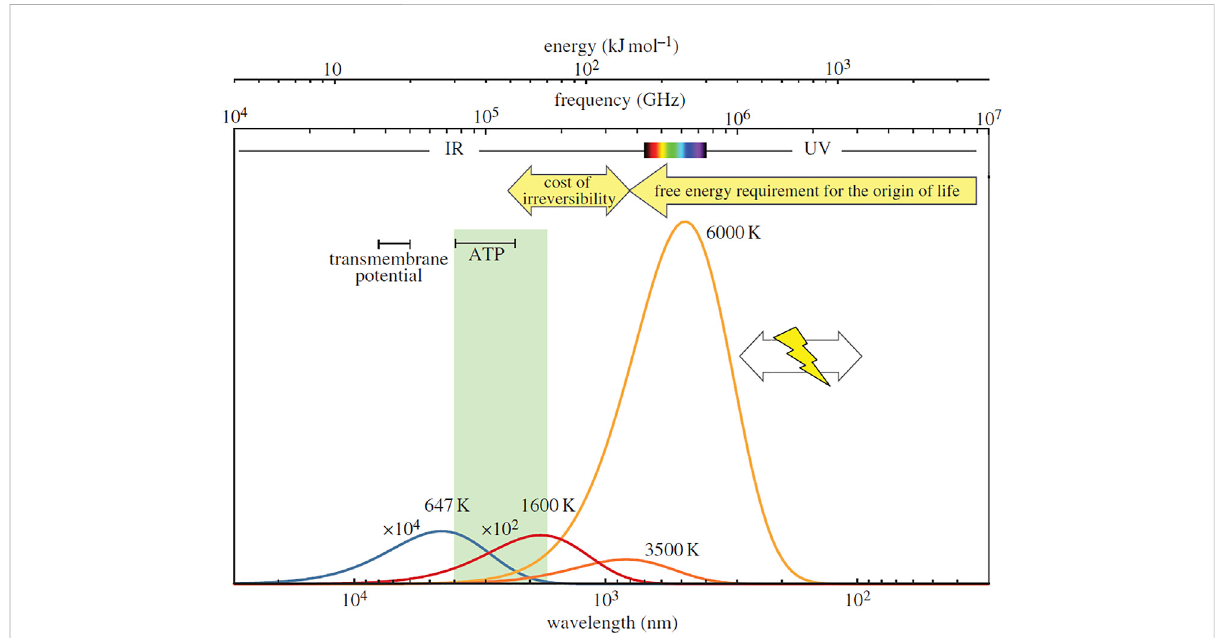
FIGURE 7 Freeenergysource requirements inlivingsystems(afterPascaletal.,2013).Theenergyavailableatthecriticalpointofwater (at647 K)isshown bytheblueline; typical Hadeanmagmatemperatures(~1600 K) are inred;thesurfacetemperaturesof examples ofM-stars (3500 K)or G-stars (e.g. Sun, 6000 K) in dark and light orange lines; and lightning (T ≥ 104 K). Pascal et al. (2013) note that a much higher potential [ca 150 kJ mol – 1 (42,43)] than the free energy potential of common biochemicals (green rectangle 30 – 70 kJ mol – 1, including ATP) was required to trigger the self- organization of life after taking into account the cost of irreversibility (yellow arrows), namely visible and UV light, as well as